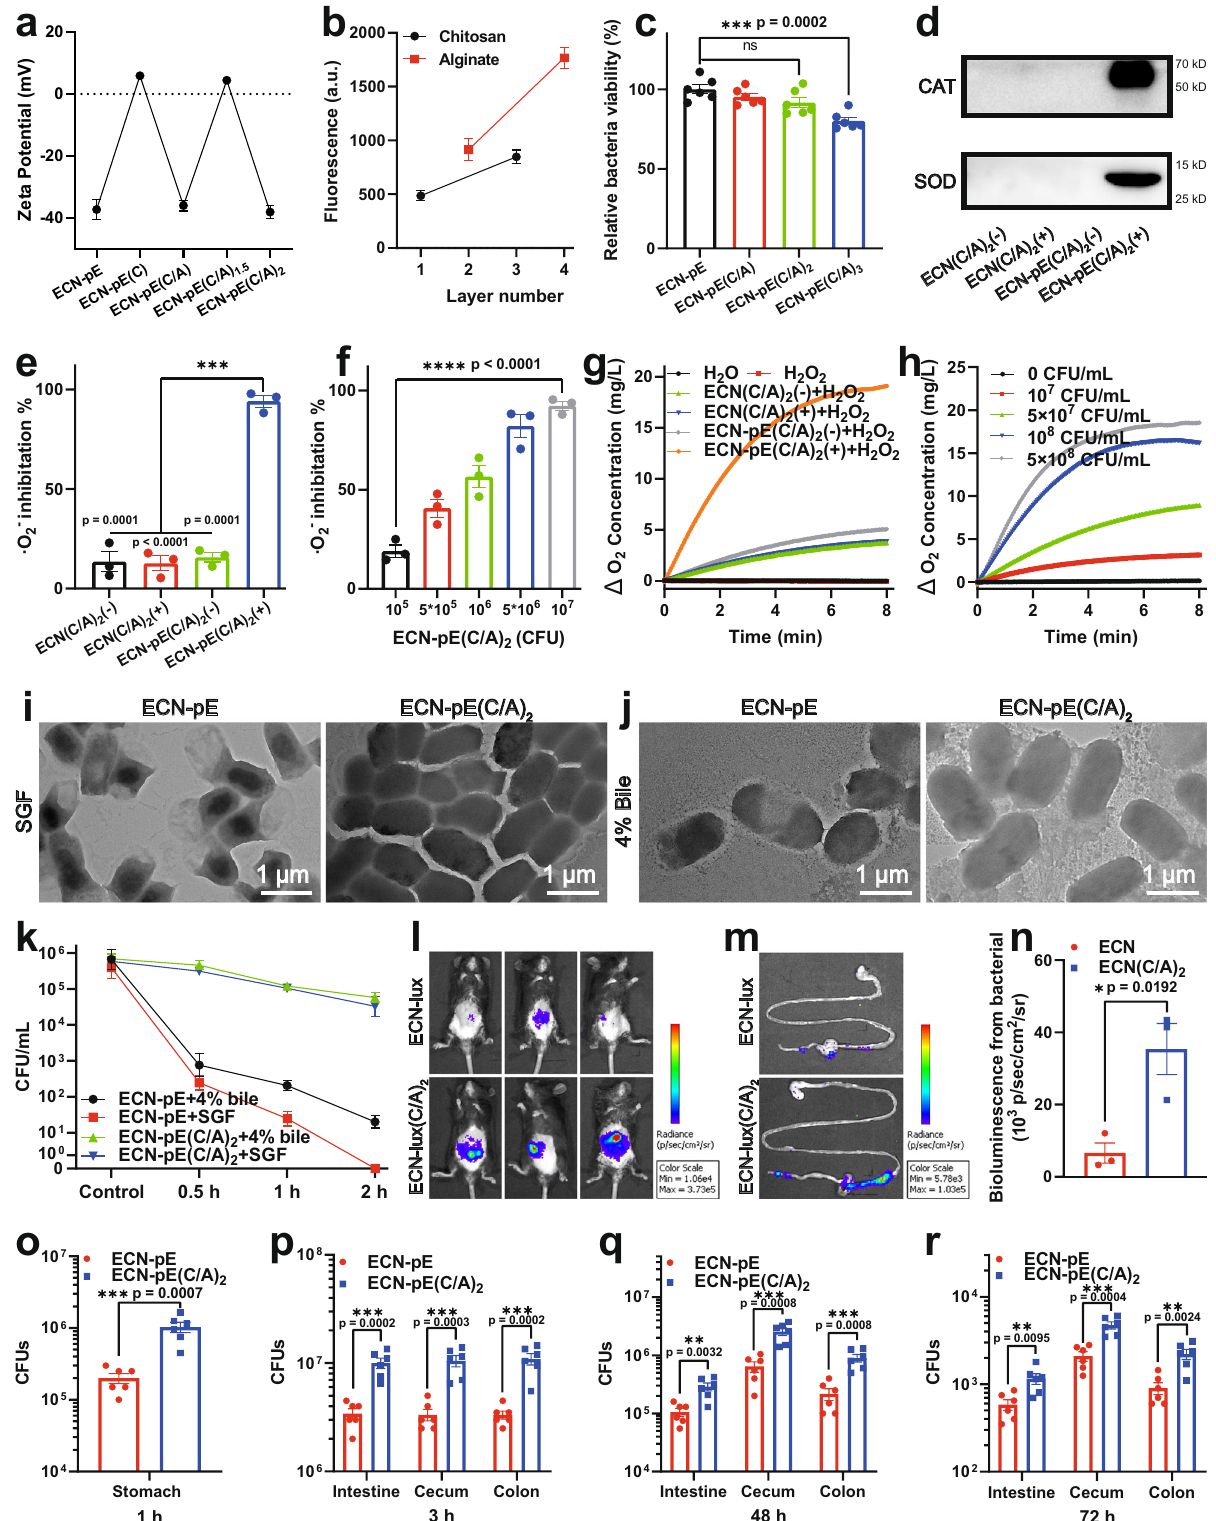
Therapeutic ef fi cacy of ECN-pE(C/A) 2 against IBD . We fi rst detected the ROS scavenging effect of ECN-pE(C/A) 2 in a DSS- induced murine IBD model by DCFH-DA (2,7-dichlorodihy- dro fl uorescein diacetate) staining. To verify the ROS eliminating capability of ECN-pE(C/A) 2 , colon tissues collected from mice with different treatments were stained with DCFH-DA. As shown